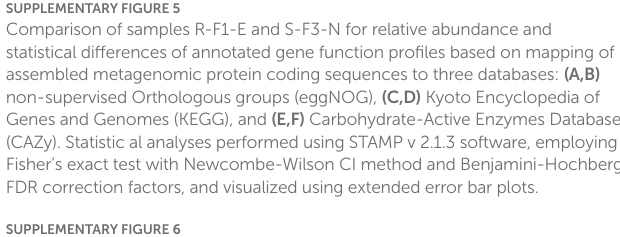
SUPPLEMENTARY FIGURE 2 Distribution heatmap of bacterial species classified with >1% relative abundance among all the 12 water samples—sequenced for V3-V4 region of 16S rRNA gene region using Illumina iSeq100 sequencing platform. The generated short amplicon reads were analyzed using EzBioCloud platform. The heatmap was generated using display R. SUPPLEMENTARY FIGURE 3 UPGMA (unweighted pair group method with arithmetic mean) clustering of water samples based on Bray-Curtis dissimilarity index at genus level. Samples were grouped in three distinctive clusters: Cluster 1 (R-F1-E and S-F3-N) irrespective of water system or geographical location, Cluster 2 (R-S1-E, R-F2-W, R-S2-W, R-F4-SE, R-S4-SE, R-F5-SE, and R-S5-SE) based on irrigation source and